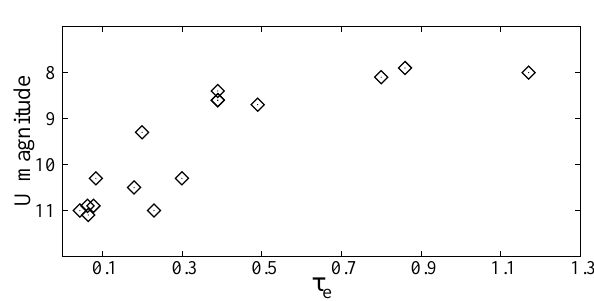
Figure 3: During the transition from the quiescent phase (U ∼ 11; bottom left) to the active phase (U ∼ 8; top right), the ionized enhanced stellar wind from white dwarf represent a new source of free electrons into the nebula, which increases the electron optical depth τ e .